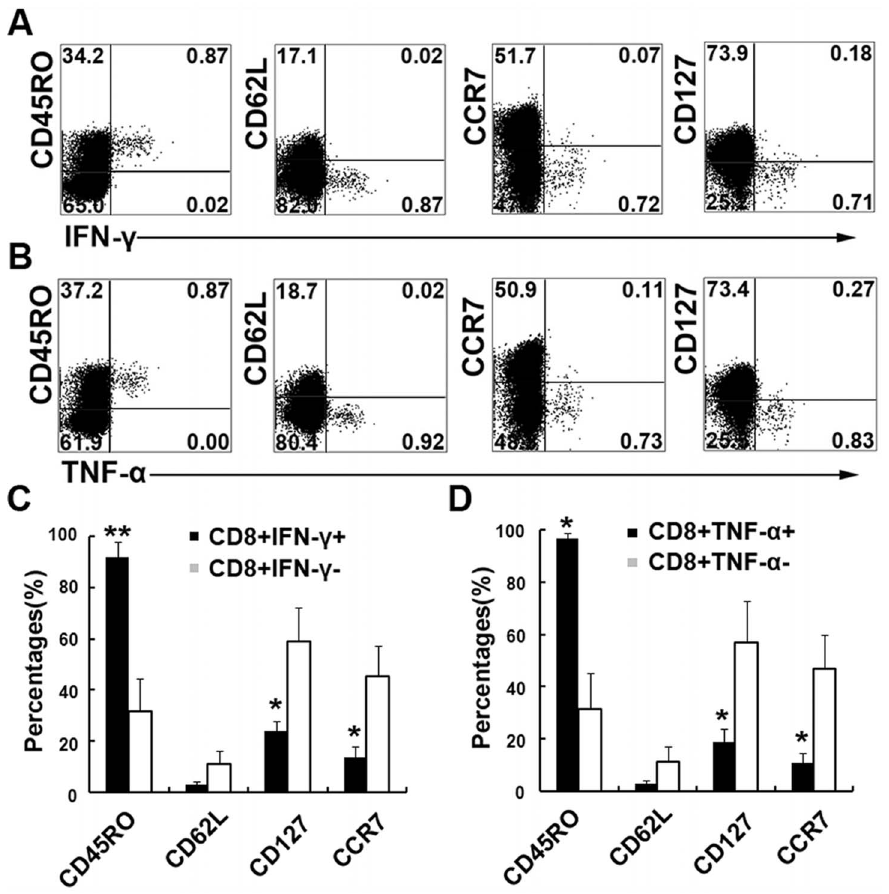
Figure 7. Memory CD8 + T cells in PFCs from TBP in response to 9aa CFP10 peptides for the production of IFN- c or TNF- a . PFCs from CFP10 peptide-responsive patients were stimulated with the indicated 9aa CFP10 peptide for 8 h. (A, B) The expression of CD45RO, CD62L, CCR7, CD127 and IFN- c (A) or TNF- a (B) by CD8 + T cells was assessed by flow cytometry. Numbers in quadrants indicate percentages of the cells in each population. (C, D) Statistical results of CD45RO, CD62L, CCR7 and CD127 expression by CD8 + IFN- c + /CD8 + IFN- c 2 cells (C) and by CD8 + TNF- a + /CD8 + TNF- a 2 cells (D). Data shown are results from three independent experiments. *, P , 0.05; **, P , 0.01.